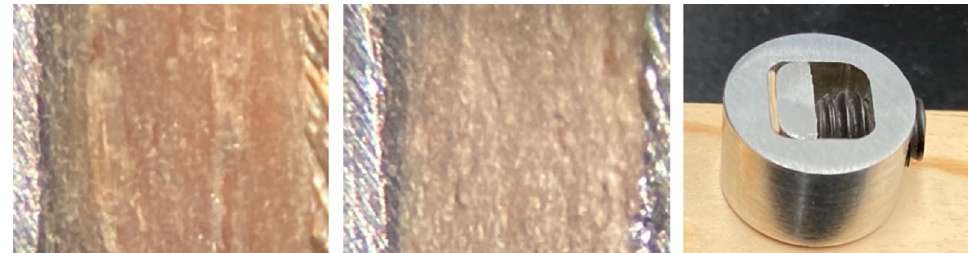
Fig. 7 Cherry (left) and red oak (center) veneer treated with iron acetate solution, the product of aged Rhodes steel wool–DW vinegar reaction, and viewed edge on along the grain (vertical axis) by optical microscopy. The scale of the photos and the average thickness of the veneer was 600 µm. The ebonized wood layer is the slightly darker band on the left side, and its thickness was estimated by ruler measurement of the photo. The third photo (right) is of the holder used to secure the veneer edge perpendicular to the optical path of the microscope. The edge of the wood (and top of the holder) was sanded to 4000 grit prior to